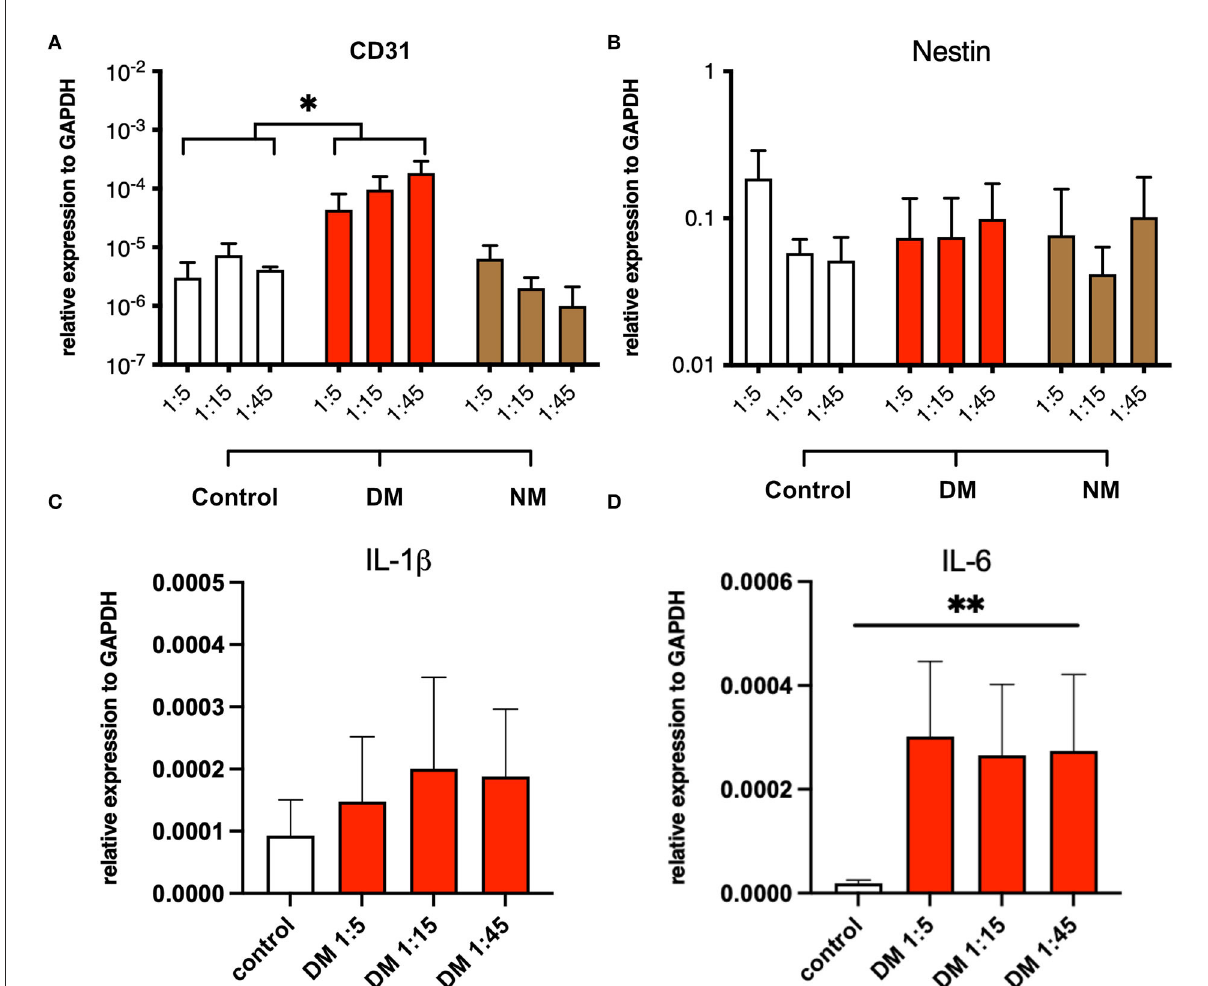
FIGURE5 Serum stimulation of cultured myotubes from DM and NM patients. (A) PECAM-1 mRNA expression was significantly enhanced upon stimulation with serum derived from DM patients. Since control samples showed low CD31 abundances also, residual presence of CD31 + cells must be considered ( * , p-value < 0.05). (B) Nestin mRNA expression levels did not change in a significant manner upon serum treatment. (C) A trend toward higher IL-1b mRNA expression was noticed without reaching statistical significance. (D) IL-6 mRNA expression was significantly upregulated ( ** , p-value <